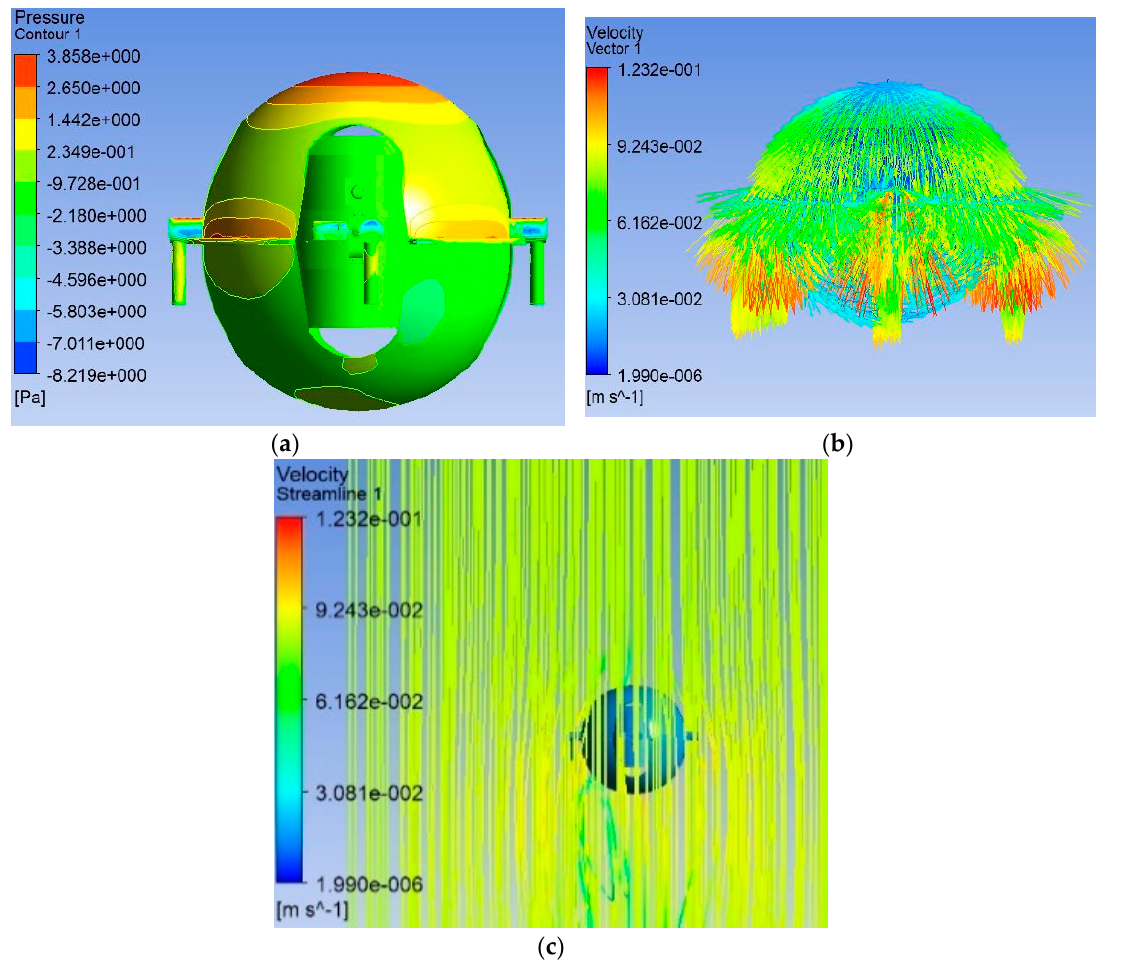
Figure 15. Down motion in heave. ( a ) Pressure contour; ( b ) Velocity vector; ( c ) Velocity streamline.